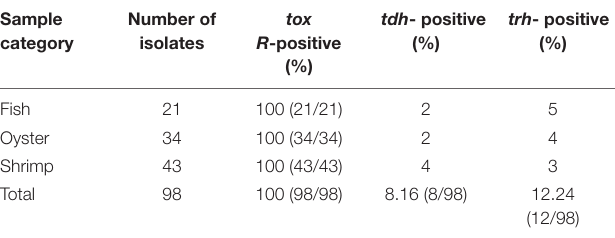
TABLE 4 | Distribution of the tox R, tdh, and trh genes in V. parahaemolyticus isolates. Sample